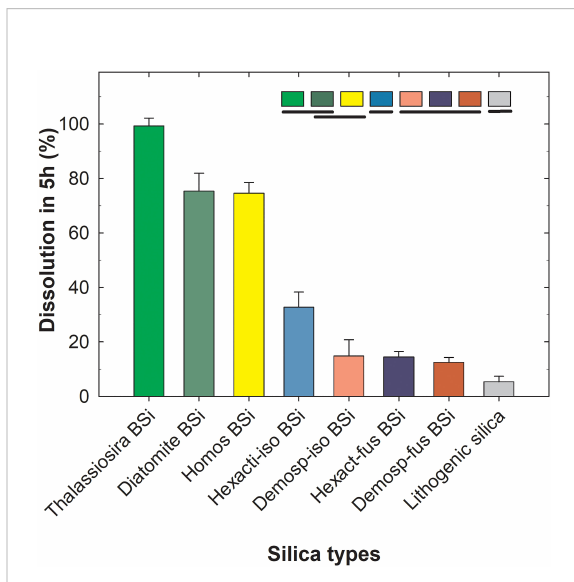
FIGURE 6 Percentage dissolution (avg ± SD) of the various silica types after 5 h in 1% sodium carbonate at 85 °C, ordered in decreasing magnitude: biogeneic silica (BSi) in the form of frustules of diatom Thalassiosira weiss fl ogii , diatom earth (diatomite BSi), spicules of homosclerophorid sponge Corticium candelabrum (Homos BSi), isolated, delaminating spicules of rosellid hexactinellid sponges (Hexact-iso BSi), isolated spicules of several shapes of demosponges (Demosp-iso BSi), spicules fused in skeletal framework of hexactinellids (Hexact-fus BSi), desmas fused in skeletal framework of demosponges (Demosp-fus BSi), and lithogenic silica represented by aluminosilicates bentonite and kaolinite. A one-way ANOVA detected signi fi cant between- type differences in average dissolution (see Supplementary Results S1 for extended statistics). “ A posteriori ” pairwise comparisons (Holm-Sidak test) are summarized graphically at the top of the graph. Silica types are ordered by decreasing magnitude in average dissolution (%) at 5 h and types that are not statistically different from each other are underlined by the same line. The graph summarizes that fresh frustules, diatomite and spicules of a homoscleromorph sponge dissolve at comparatively higher rates than the rest of assayed BSi, but with no signi fi cantly difference from each other. The isolated spicules of hexactinellids dissolve more slowly than the former BSi types, but they still do it two fold faster than the frameworks of fused spicules of hexactinellids, the isolated spicules of demosponges, and the desmas frameworks of demosponges, the three of which do not dissolve differently from each other. All assayed types of biogenic silica dissolved faster than the lithogenic